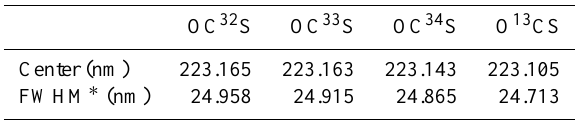
Table 2. Reconstructions of absorption cross sections of OCS iso- topologues using Gaussian fitting.